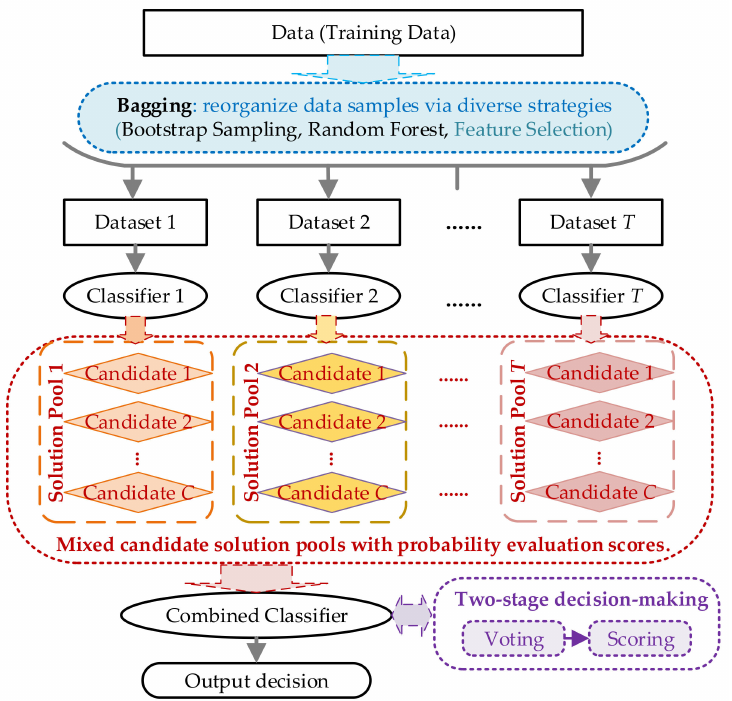
Figure 1. Proposed framework of non-intrusive load monitoring (NILM)-oriented ensemble